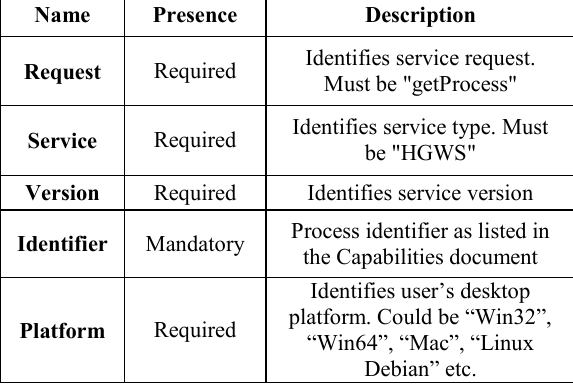
Table 1. getProcess request parameters